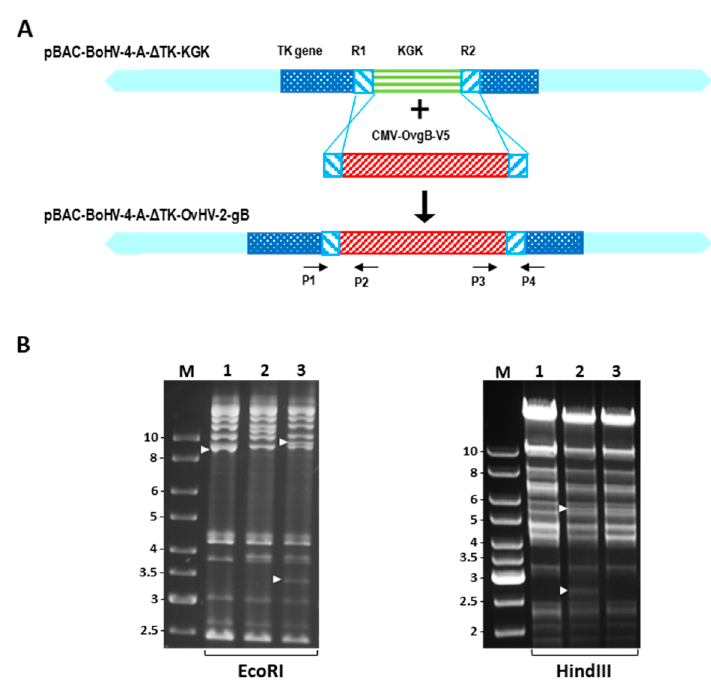
Figure 1. Construction of the recombinant BoHV-4 expressing OvHV-2 gB. ( A ) Diagram illustrates the replacement of the KGK cassette in the TK locus of pBAC-BoHV-4-A ∆ TK-KGK with the OvHV-2 ORF8 cassette (CMV-OvgB-V5) to generate pBAC-BoHV-4-A ∆ TK-OvHV-2-gB. Homologous recombination was performed using the R1 and R2 sequences present in the BoHV-4 TK gene using a galactokinase K selection system in E. coli SW102. ( B ) Restriction profile following digestion with Eco RI and Hin dIII showing the integrity of the constructed viruses. Lanes: M, GeneRuler DNA Ladder molecular size marker (in Kbp); 1, pBAC-BoHV-4-A wild-type; 2, pBAC-BoHV-4-A ∆ TK-KGK; 3, pBAC-BoHV-4-A ∆ TK-OvHV-2-gB. White arrows indicate expected differential bands generated by DNA digestion in each genome.